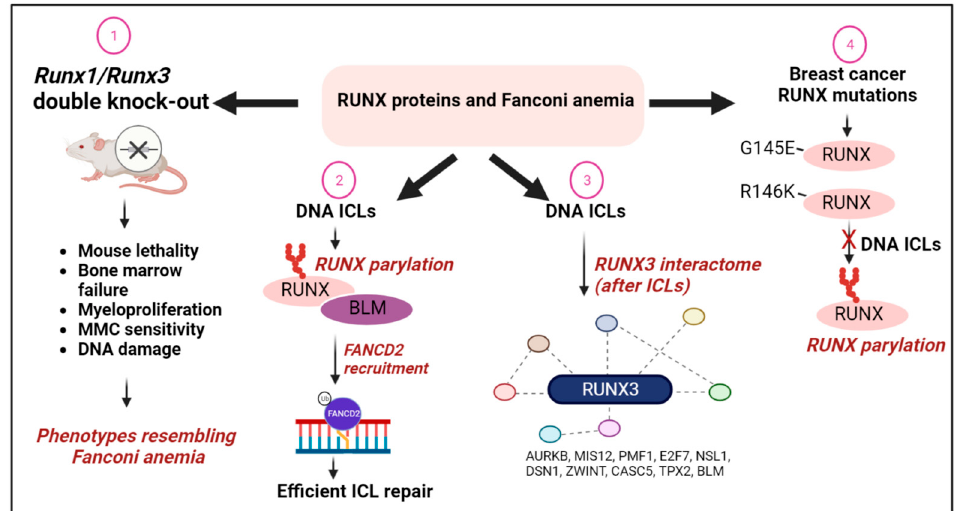
Figure 5. RUNX proteins and the FA pathway of DNA repair. The multiple lines of evidence linking RUNX proteins with the FA pathway of DNA repair are summarized here. 1. Runx1/Runx3 (DKO) mice experienced mortality due to either BMF or a myeloproliferative disease, and cells derived from such mice had an elevated sensitivity to DNA ICLs, reminiscent of phenotypes manifested by FA patients. 2. RUNX proteins were poly(ADP) ribosylated or PARylated after DNA damage in a PARP-dependent manner. RUNX proteins interacted and promoted the recruitment of mono-ubiquitinated FANCD2 to sites of DNA ICLs and promoted efficient DNA repair. 3. In the presence of DNA ICLs, RUNX3 has an increased interaction with the kinetochore complex (AURB, DSN1, CASC5, MIS12, ZWINT, PMF1, NSL1, and TPX2), the E2F7 transcription factor, and BLM (adapted from Tayet et al. [60]), of which the RUNX3-BLM interaction was shown to promote FANCD2 recruitment to sites of DNA ICLs. 4. RUNX1 walker domain mutations (G141 and R142 residues) from breast cancers were defective for DNA damage-dependent RUNX PARylation.